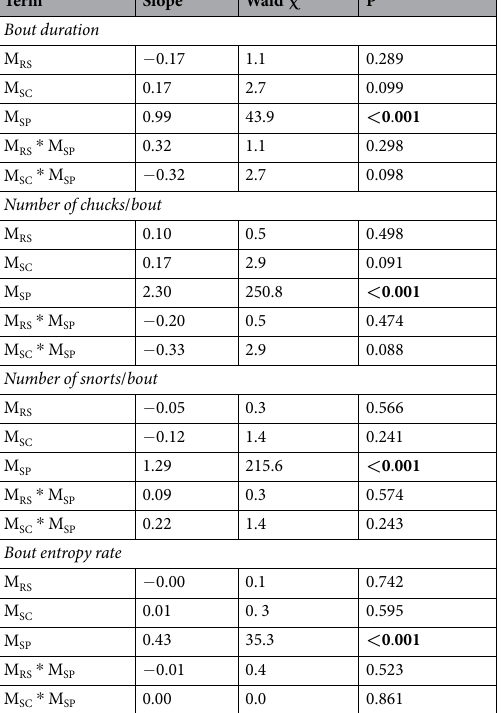
Table 2. The effect of male residency (M RS ; resident or bachelor), singing context (M SC ; spontaneous or induced) and song progression (proportion of song duration; M SP ) on bout duration, the number of chucks and snorts per bout, and bout entropy rate in hyrax male songs. df = 1 in all effect